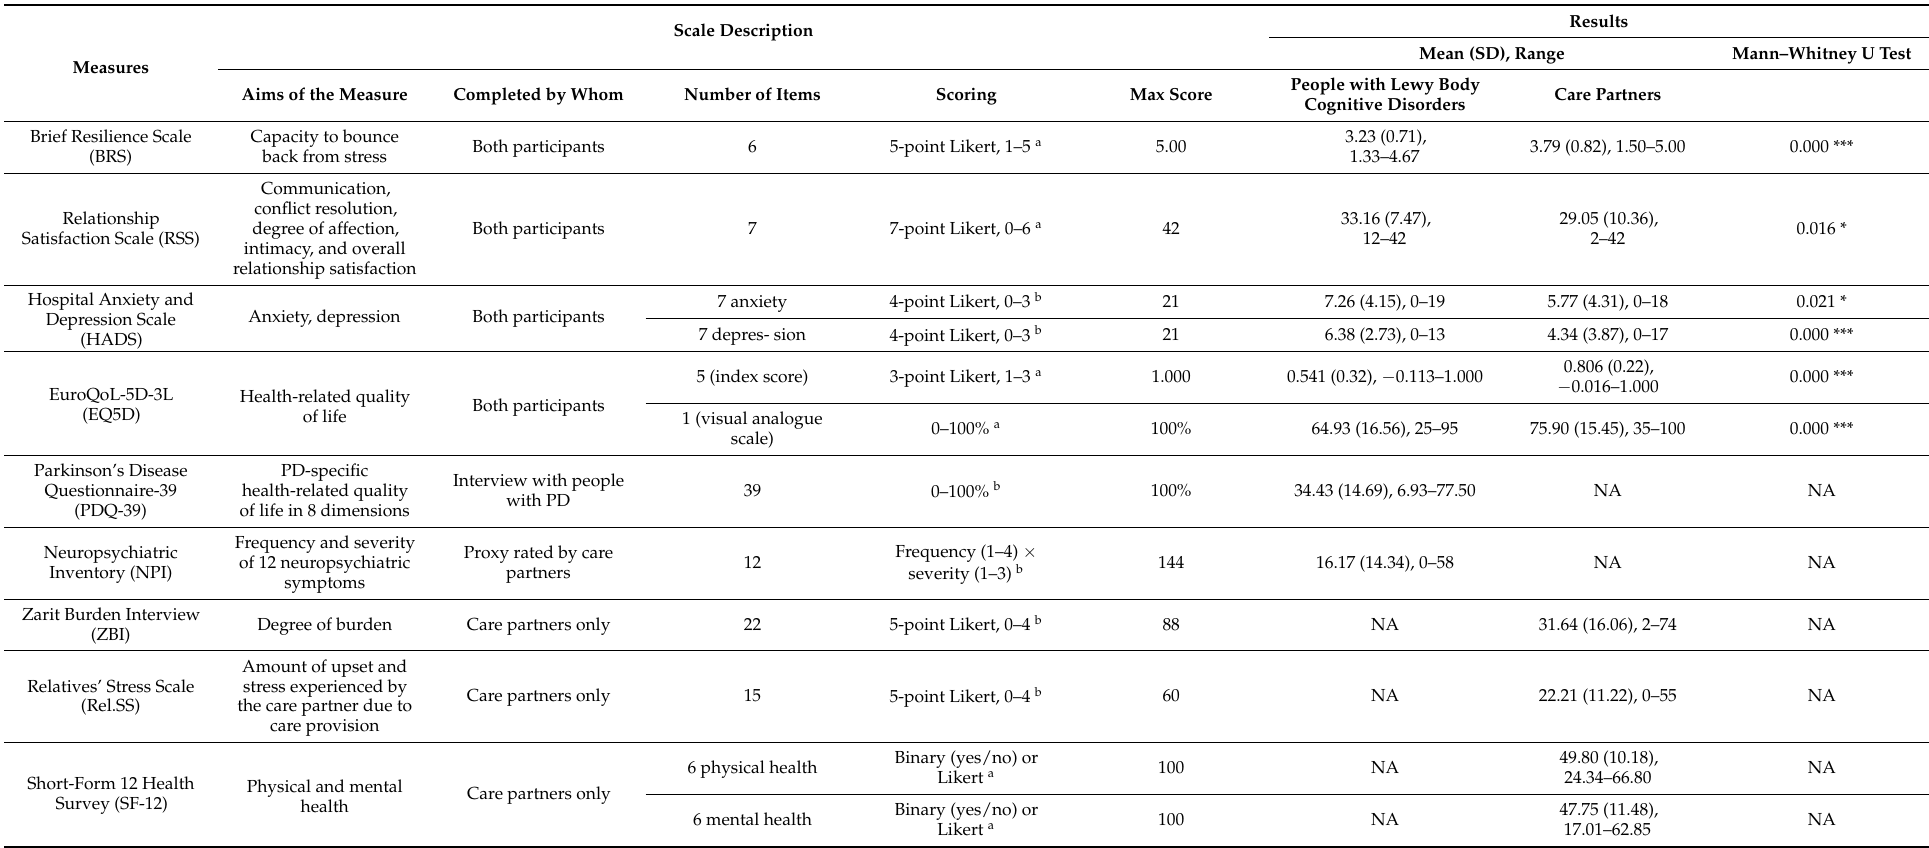
Table 1. Descriptions and values of measures in people with Lewy body-related cognitive disorders and care partners ( n = 76